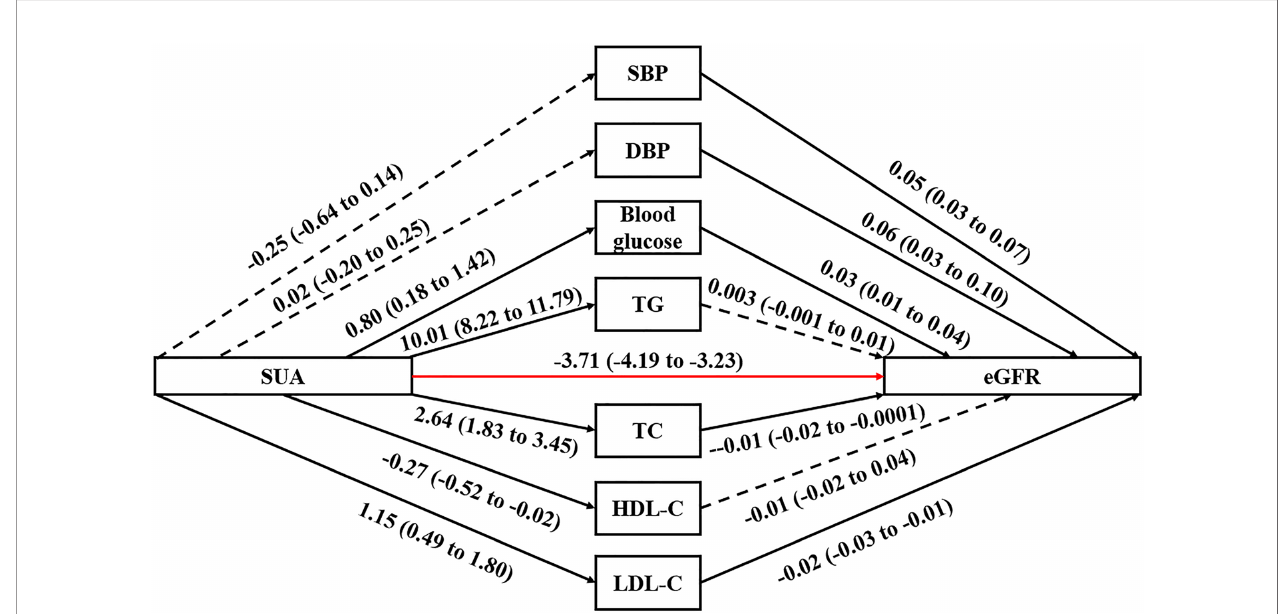
FIGURE 1 | Path diagram for mediational model. SUA, serum uric acid; eGFR, estimated glomerular fi ltration rate; SBP, systolic blood pressure; DBP, diastolic blood pressure; TG, triglyceride; TC, total cholesterol; HDL-C, high-density lipoprotein cholesterol; LDL-C, low-density lipoprotein cholesterol. The solid arrows represent a signi fi cant effect, and the dashed arrow represents a nonsigni fi cant effect. The red arrow represents the association between SUA and eGFR that excluded the effects of the seven potential mediators. The regression linear coef fi cient b and 95% CIs are positioned beside each